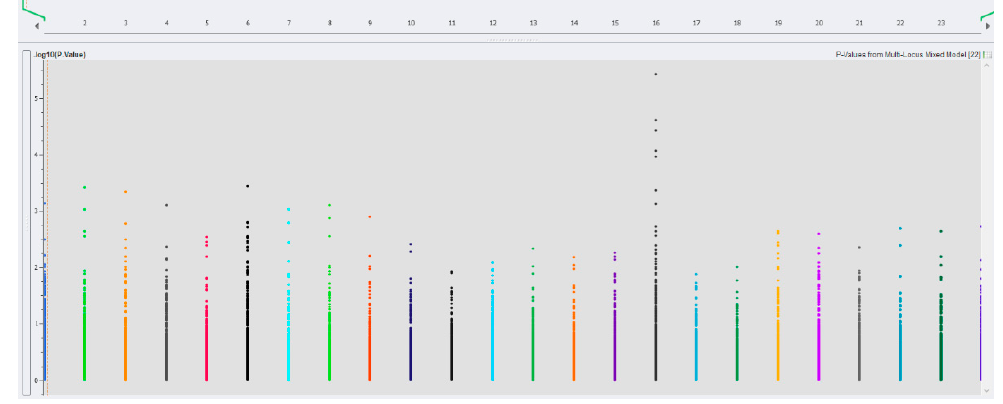
Figure 1. Genome-wide association of SNPs and body weight at 180 dph using a multi-locus mixed model ( Y -axis represents the − log10 ( p -values) and X -axis represents chromosome of Asian seabass). The proportions of variation explained by the three most significant SNPs were 1.9, 1.6, and 0.01%, with a total of 3.51%.